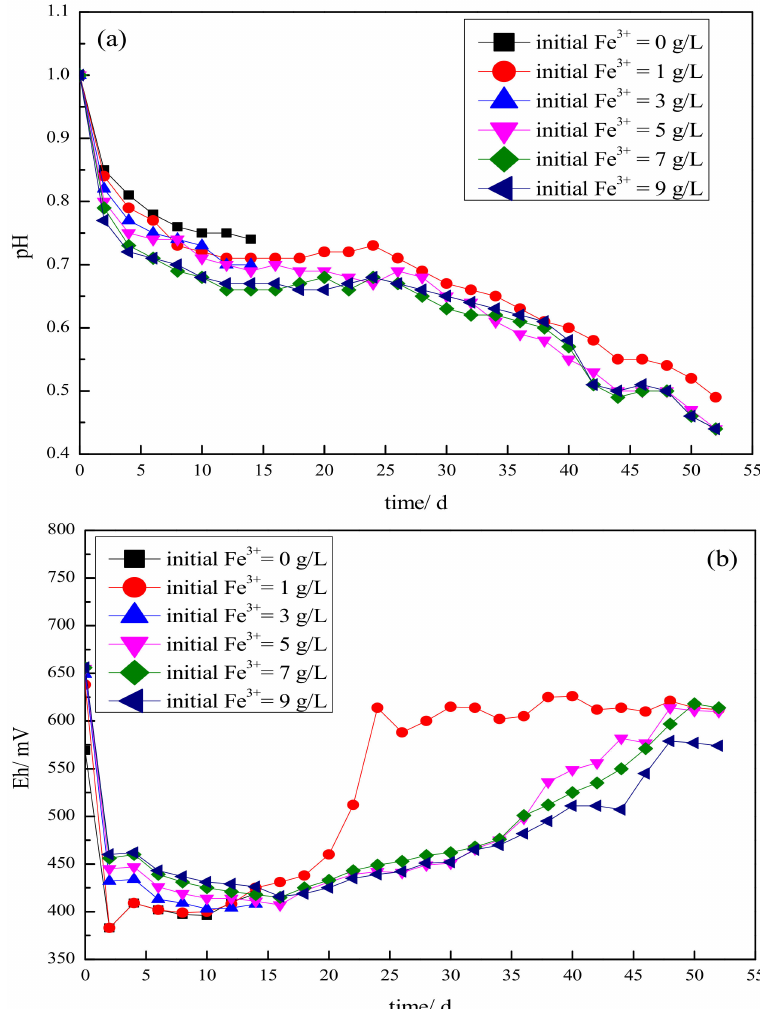
Figure 2. Changes in pH ( a ) and Eh ( b ) in solutions with